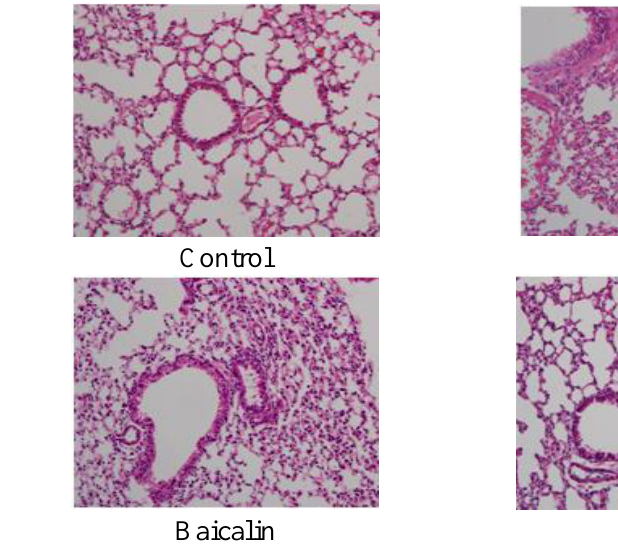
Figure 1. The pathological examination of the lungs of BALB/c mice and the histology scores revealed marked differences between groups. After mice were infected with Mycoplasma pneumoniae for 3 days, they were treated with 16 μg/mL Baicalin and 100 μg/mL Qinbai for 6 days. Experiments were repeated